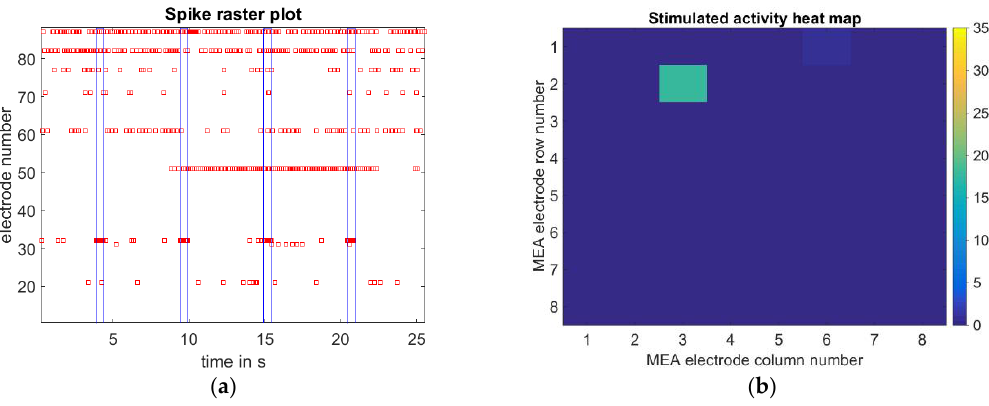
Figure 9. ( a ) Raster plot single-cell stimulation. ( b ) Single-cell stimulation activity heat map.